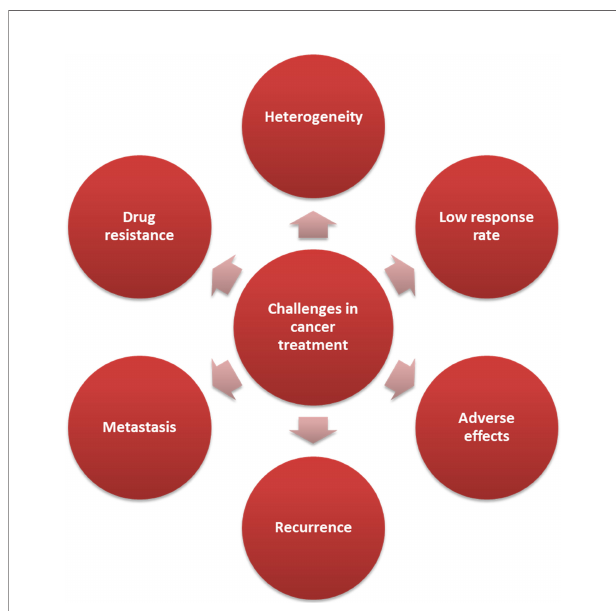
FIGURE 1 | The effective cancer treatment can be undermined by many key